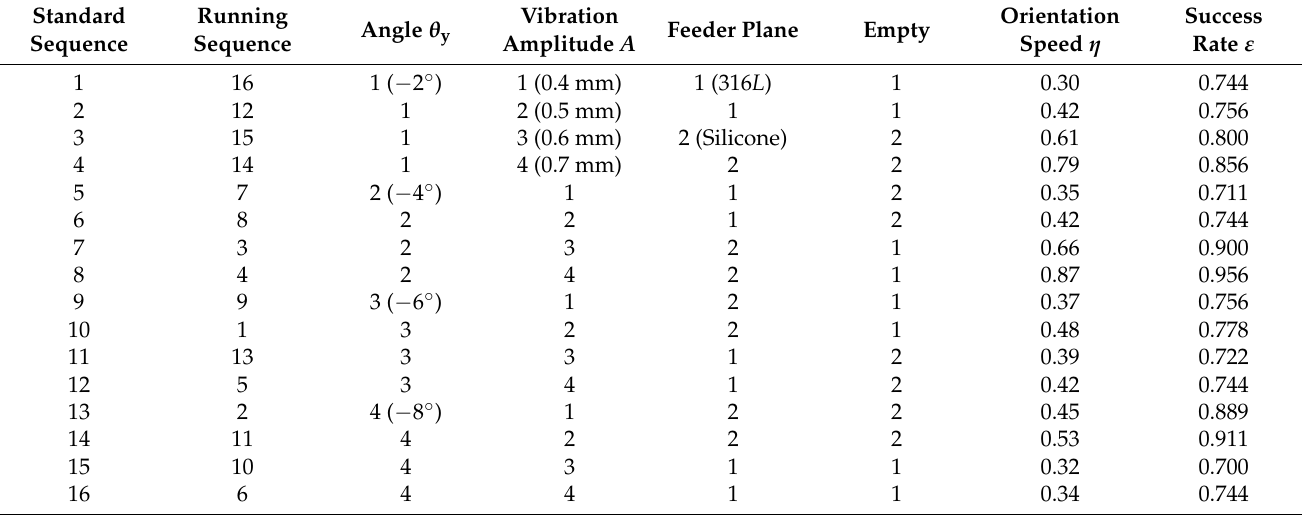
Table 3. Experimental protocol and results.